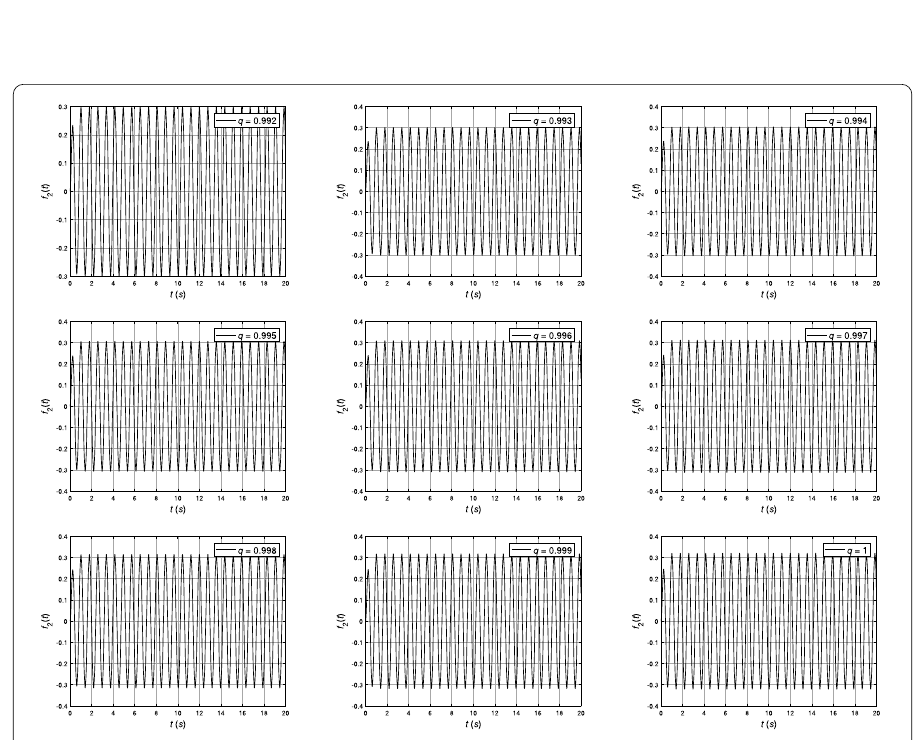
Figure 5 The state variable f 2 ( t ) of the controlled system (34) for q = 0.992,0.993,0.994,0.995,0.996,0.997,